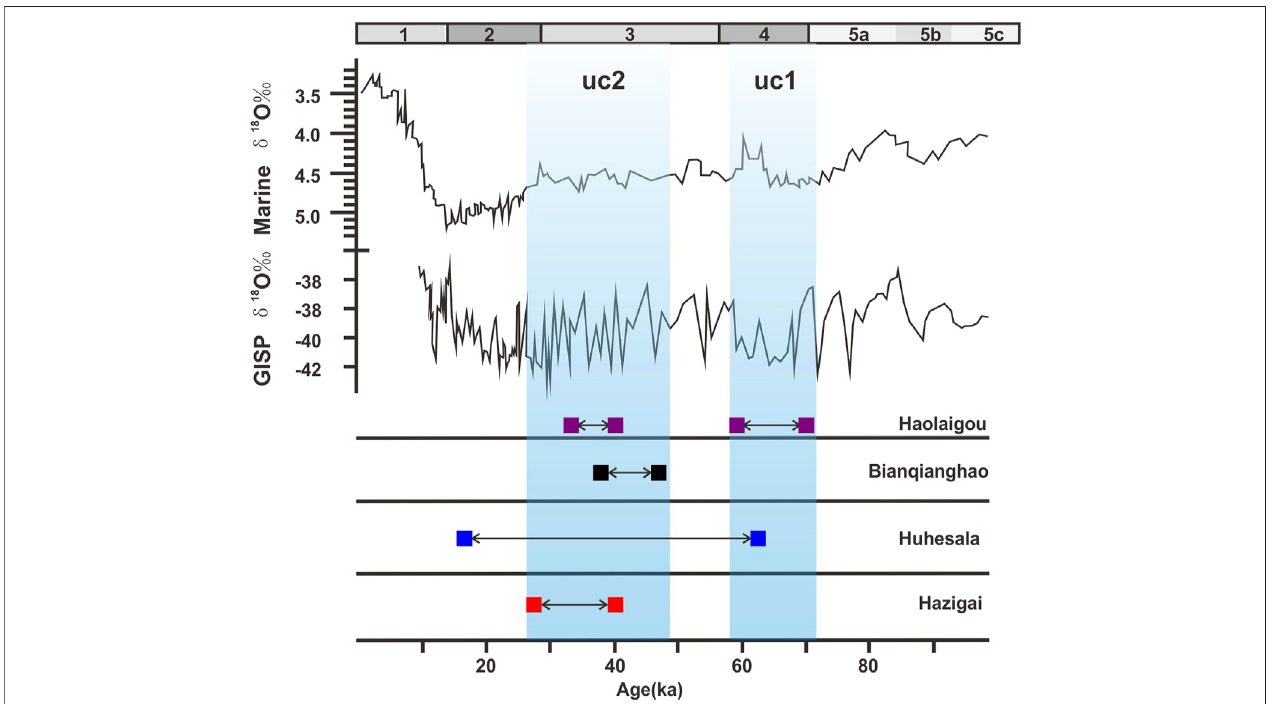
FIGURE 5 | Correlations between the timing of unconformities derived from four sedimentary sections and climatic change curves during the Late Quaternary. Marine oxygen isotope curve and (GISP) are from Shackleton et al. (1983) and Yao (1999), respectively. Light blue regions show the interval of the sedimentation (uc1 and